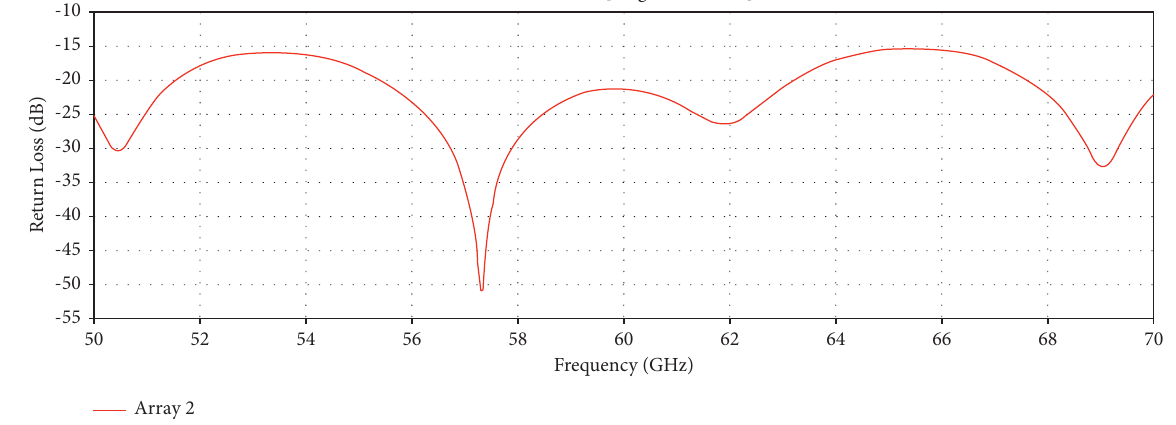
Figure 4: Simulated free-space return loss of Array 2.